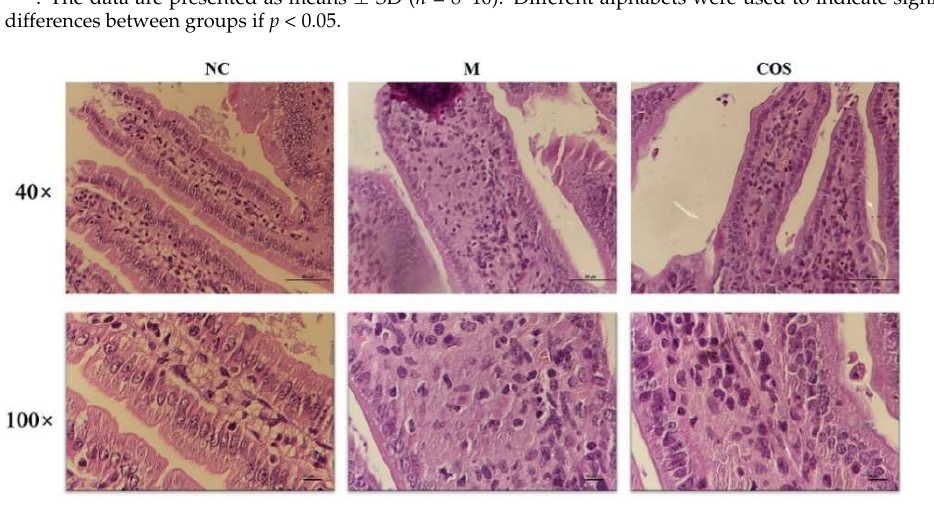
Figure 10. H&E staining of small intestinal villi. Compared with the model group, COS pretreatment increased villi height and the microvilli in the NC group and COS group can be seen under high magnification, while the microvilli in the model group disappear. Table 2. The ratio of villus height/crypt depth.